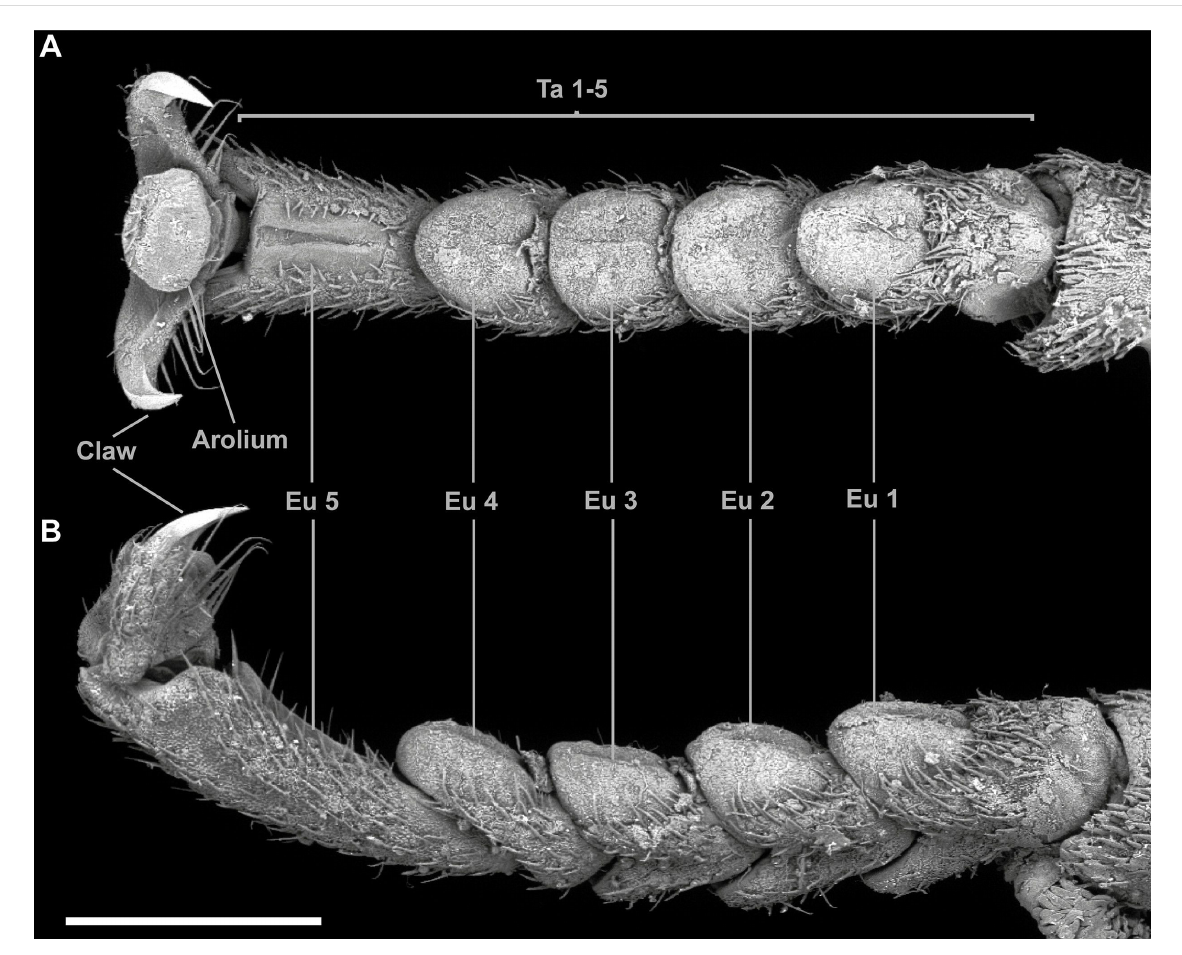
Figure 4: Scanning electron microscopy (SEM) images of a typical phasmatodean tarsus. Orestes draegeri Bresseel & Constant, 2018. (A) Ventral view. (B) Lateral view. Ta1–5, tarsomeres; Eu1–5, euplantulae; Cl, claw; Ar, arolium. Scale bars: 1 mm.